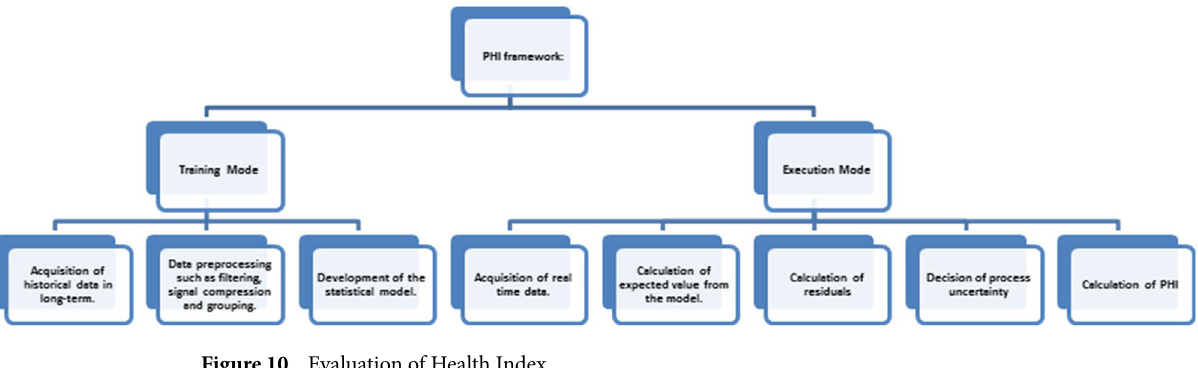
Figure 10. Evaluation of Health